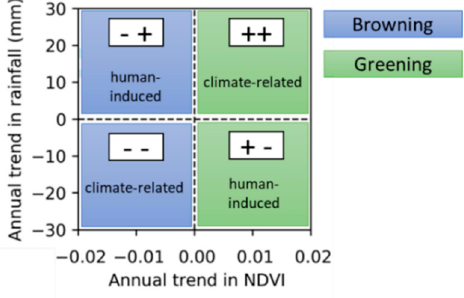
Figure A2. Interpolation. ( a ) Interpolation of a pixel’s annual maximum NDVI time series (blue) through a three-year maximum moving window (green). The data gap in 2003 is interpolated; ( b ) Annual maximum value composite (MVC) with gaps produced by Landsat-7 ETM+ SLC error and clouds; ( c ) Interpolated MVC through applying a three-year maximum moving window.